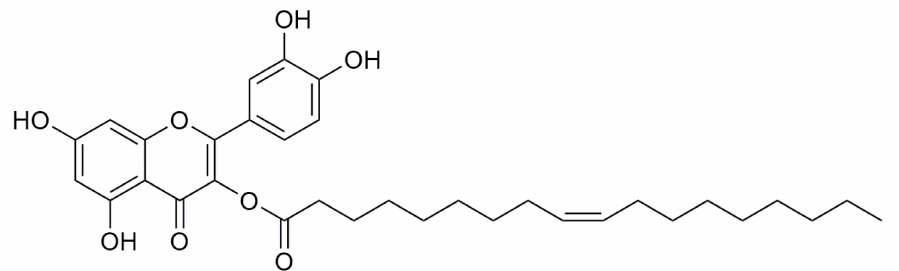
Figure 2. AV2: Quercetin’s oleoyl